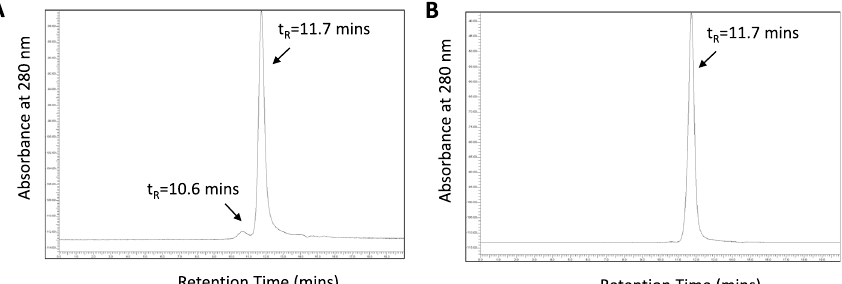
Fig. 3 Representative SE-HPLC chromatograms for A BnDTPA-trastuzumab-NLS and B trastuzumab on a BioSep SEC-s4000 column (Phenomenex, Torrance, CA, USA) eluted with 100 mM NaH 2 PO 4 buffer, pH 7.0 at a flow rate of 0.8 mL/min with UV detection at 280 nm. Trastuzumab and BnDTPA-trastuzumab-NLS exhibited one major peak with retention time (t R 11.7 min) but BnDTPA-trastuzumab-NLS exhibited a second peak at = t R 10.6 min. This small second peak may be due to cross-linking of BnDTPA-trastuzumab after reaction with = Sulfo-SMCCrequired to introduce maleimide groups for conjugation to the thiol on cysteine in NLS